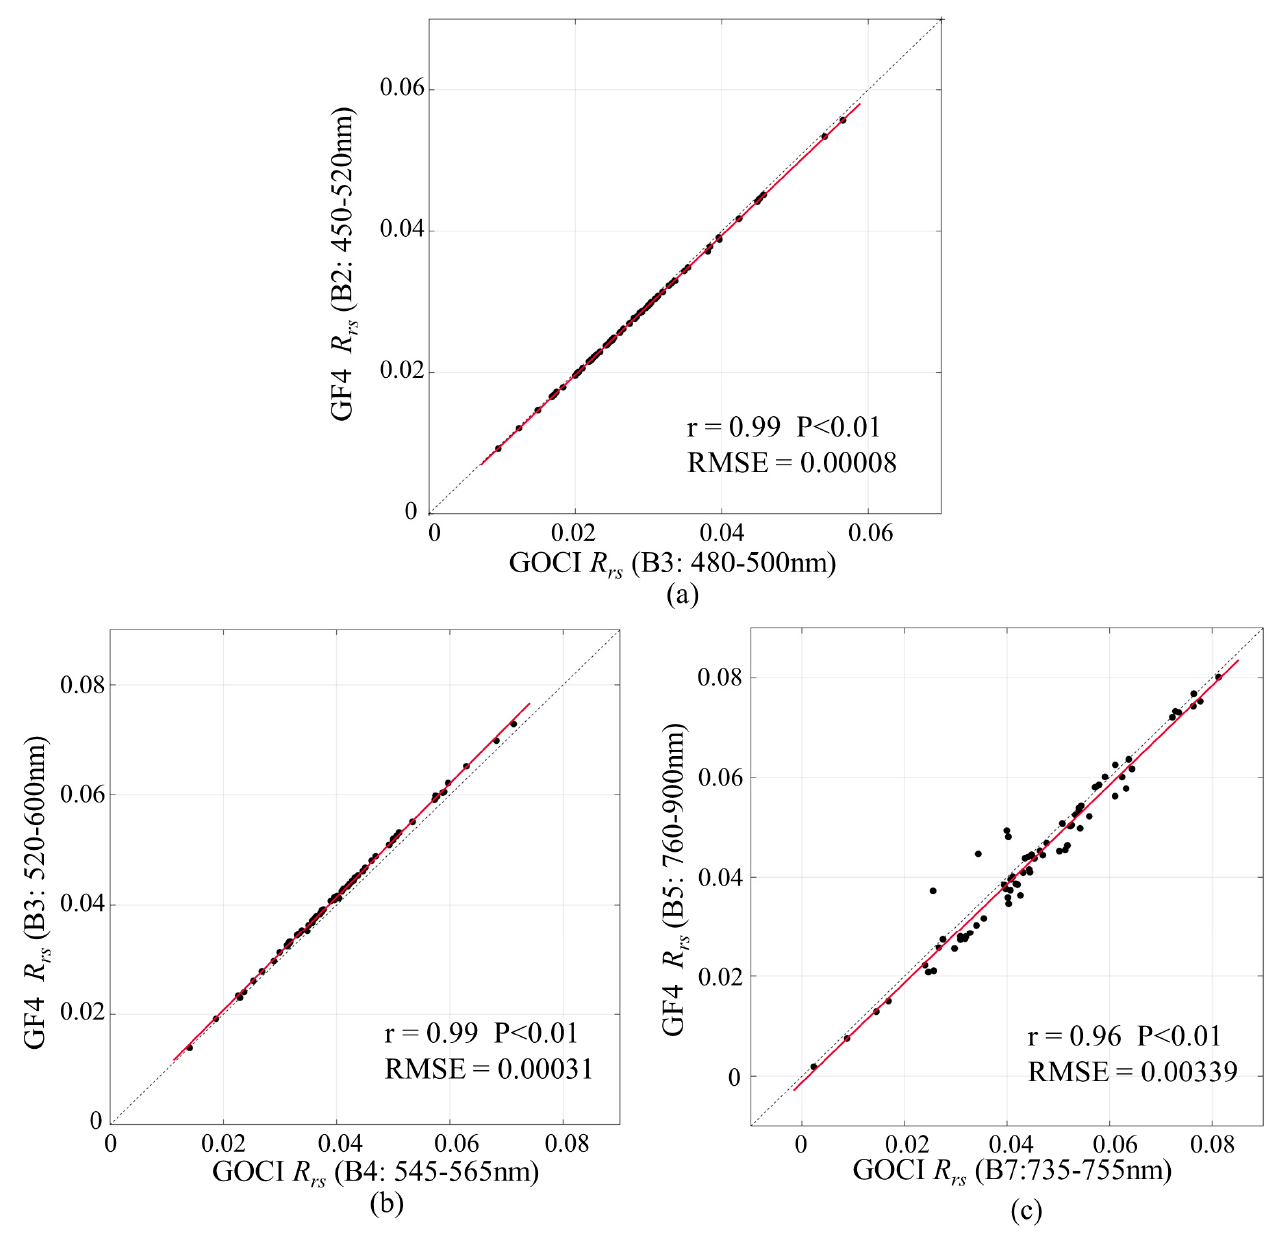
Figure 2. ( a – c ) The R rs comparisons of equivalent bands between the GOCI and GF-4 based on the in-situ data. The black dotted lines show the 1:1 relationship, and the red solid line represents the linear regression result.